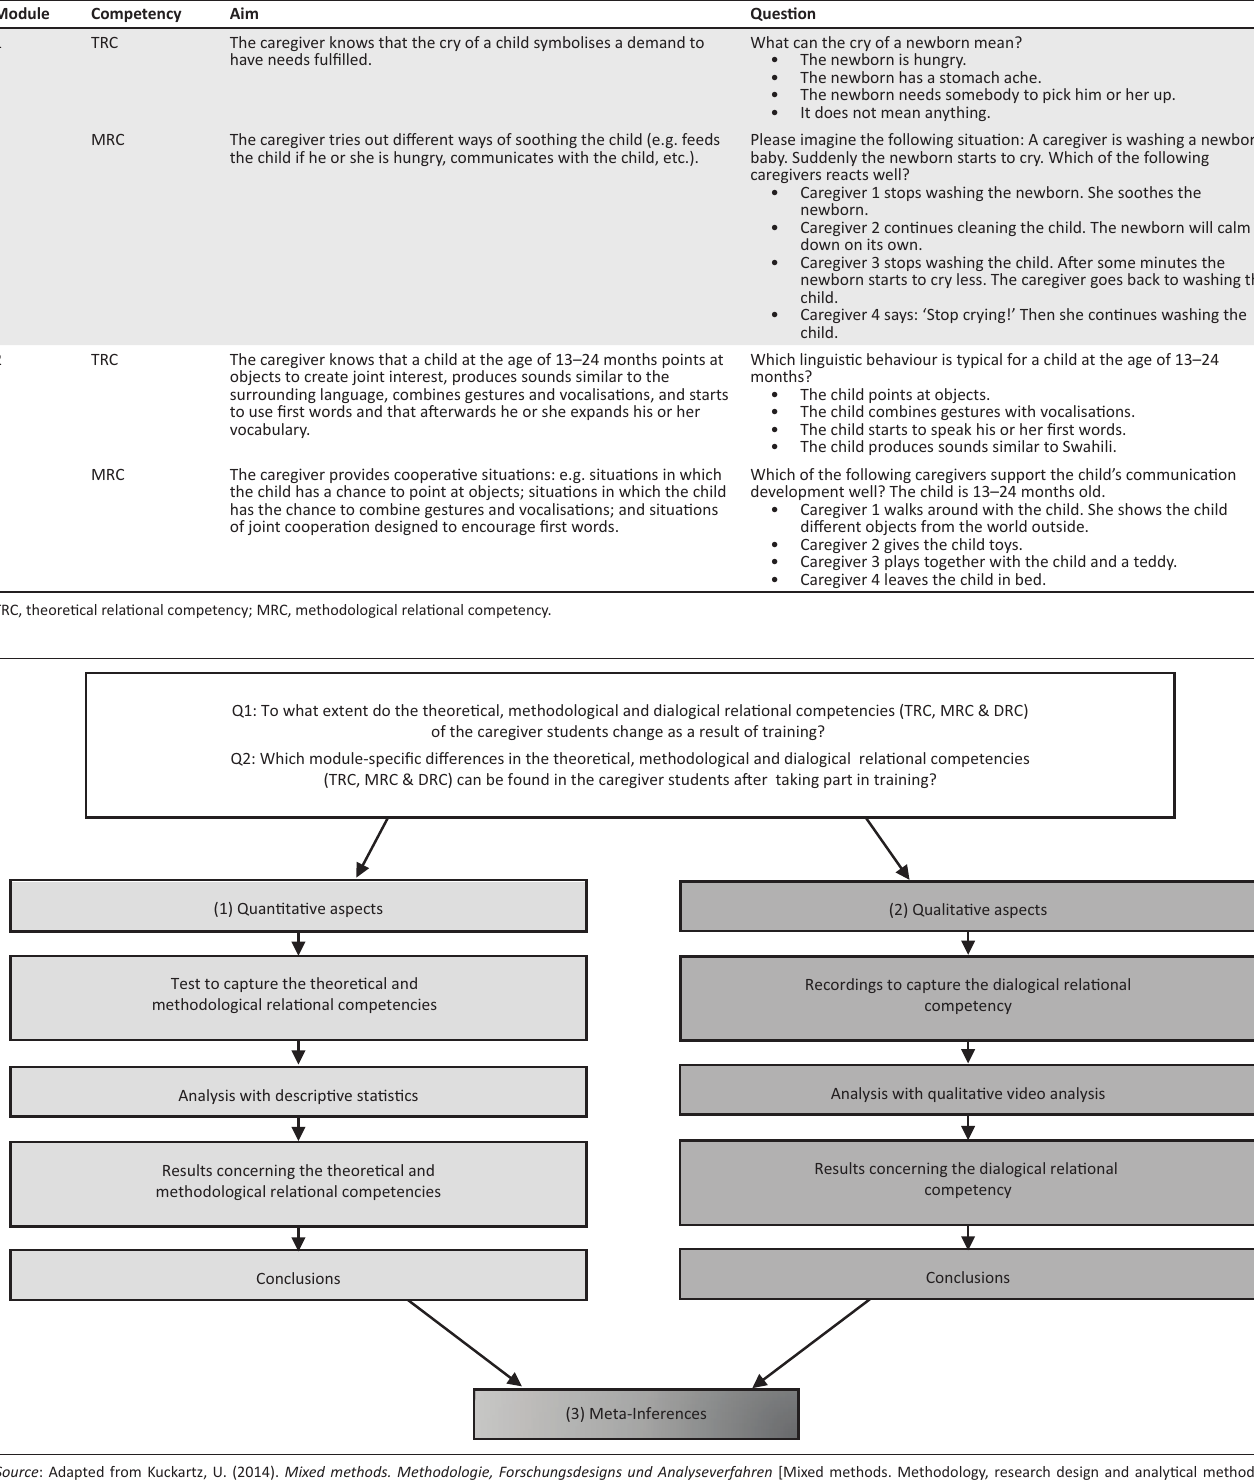
TABLE 2: Extract from detailed goal descriptions and subsequent questions from the informal competency test for modules 1 and 2. Module